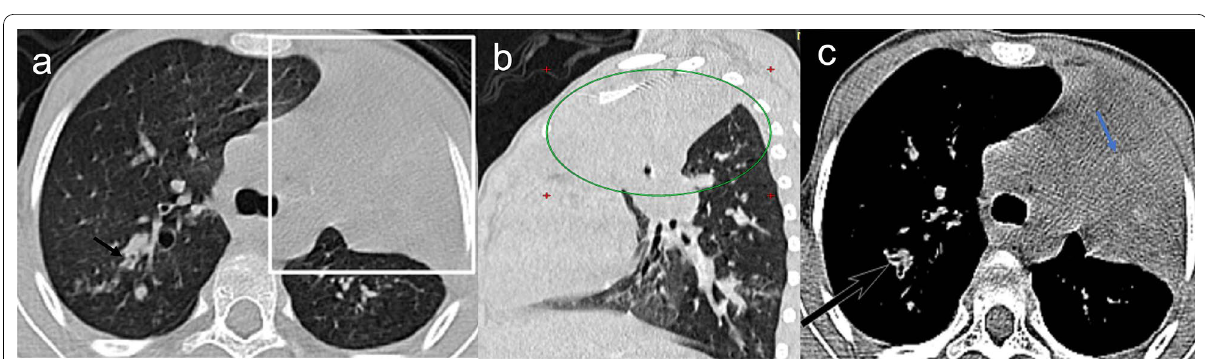
Fig. 7 A 10-year-old female diagnosed with usual interstitial pneumonia (IPF) complaining with progressive dyspnea, HRCT chest a axial cut and b minimum intensity projection (MinIP) showed bilateral fairly symmetric mainly lower lobes reticulations, with traction bronchiolectasis, bronchiolectasis and honeycombing (arrow), CT score 18